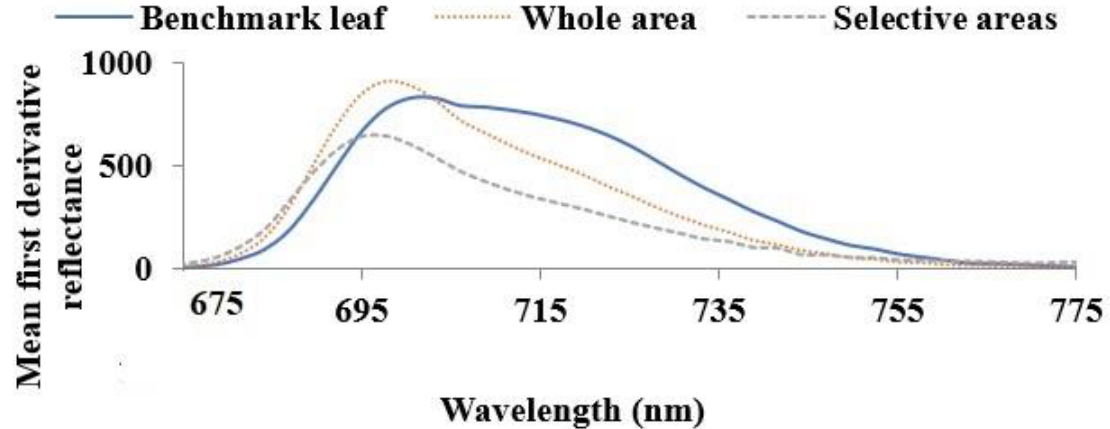
Figure 5. Mean the first derivative of the reflectance of healthy (benchmark leaf) and unhealthy (whole and selective areas) leaves in the 650 nm to 800 nm range to compare the curve pattern of healthy and unhealthy leaves.